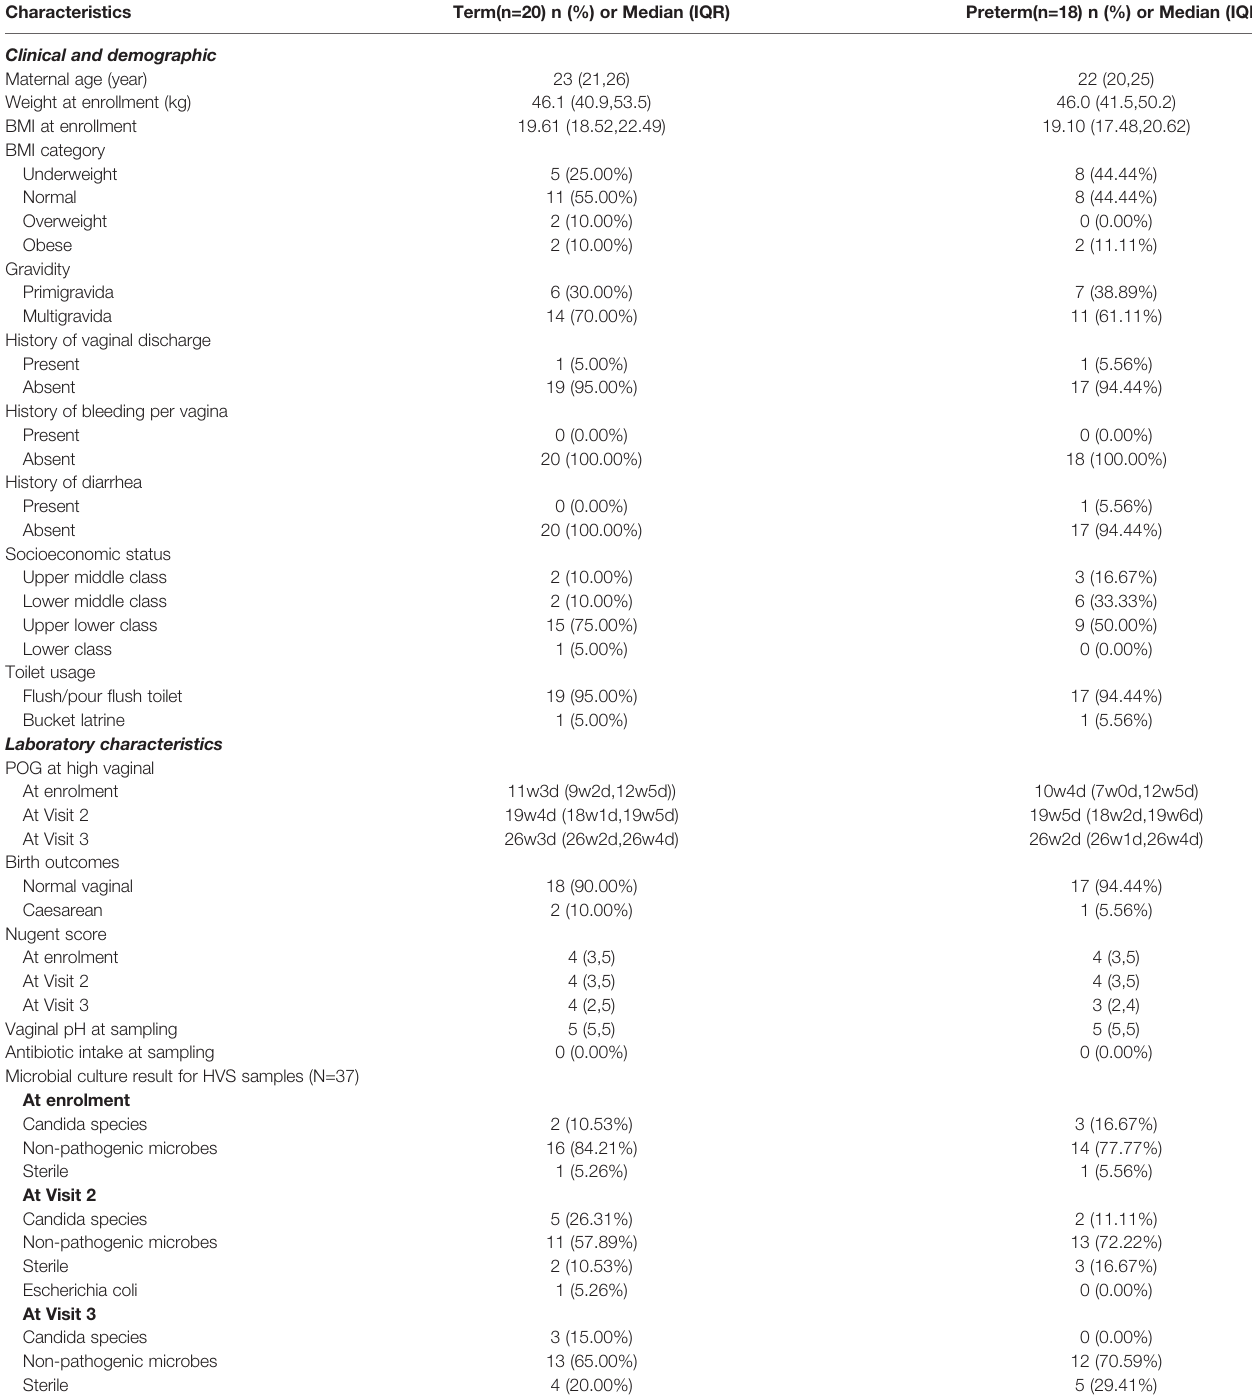
TABLE 1 | Relevant characteristics of the enrolled study participants (n=38) of the Interdisciplinary Group for Advanced Research on Birth Outcomes-DBT India Initiative (GARBH-Ini) Cohort, Haryana, India.